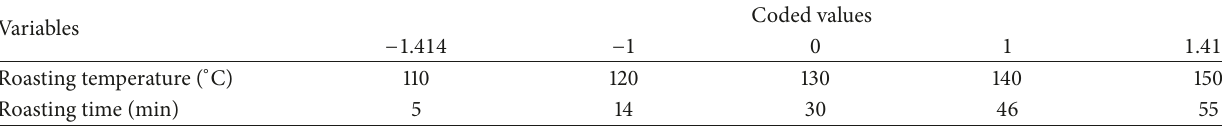
Table 1: Independent variables and their levels in central composite